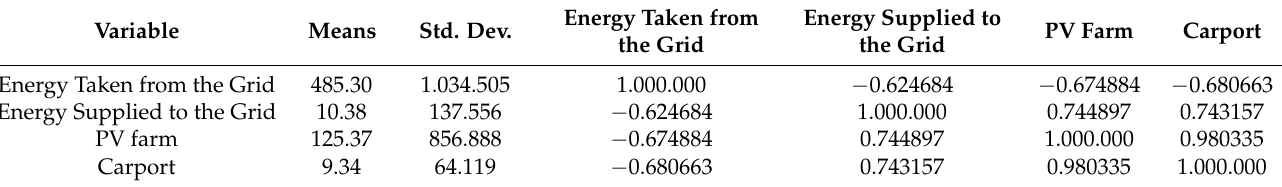
Table 1. A summary of the statistical values of the individual variables.